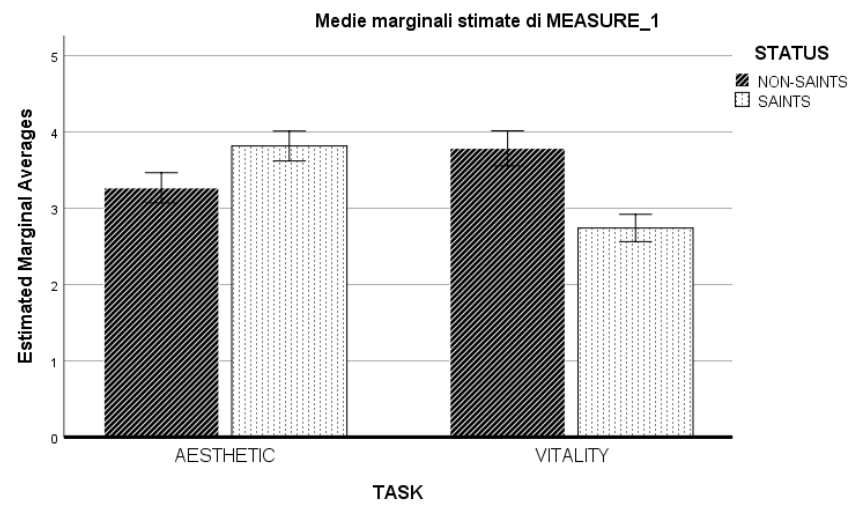
Figure 1. Bar graph showing the interaction between task (Aesthetic and Vitality judgment) and stimulus category (Saint, striped bars; non–Saint, dotted bars). Error bars represent 95% confidence intervals.